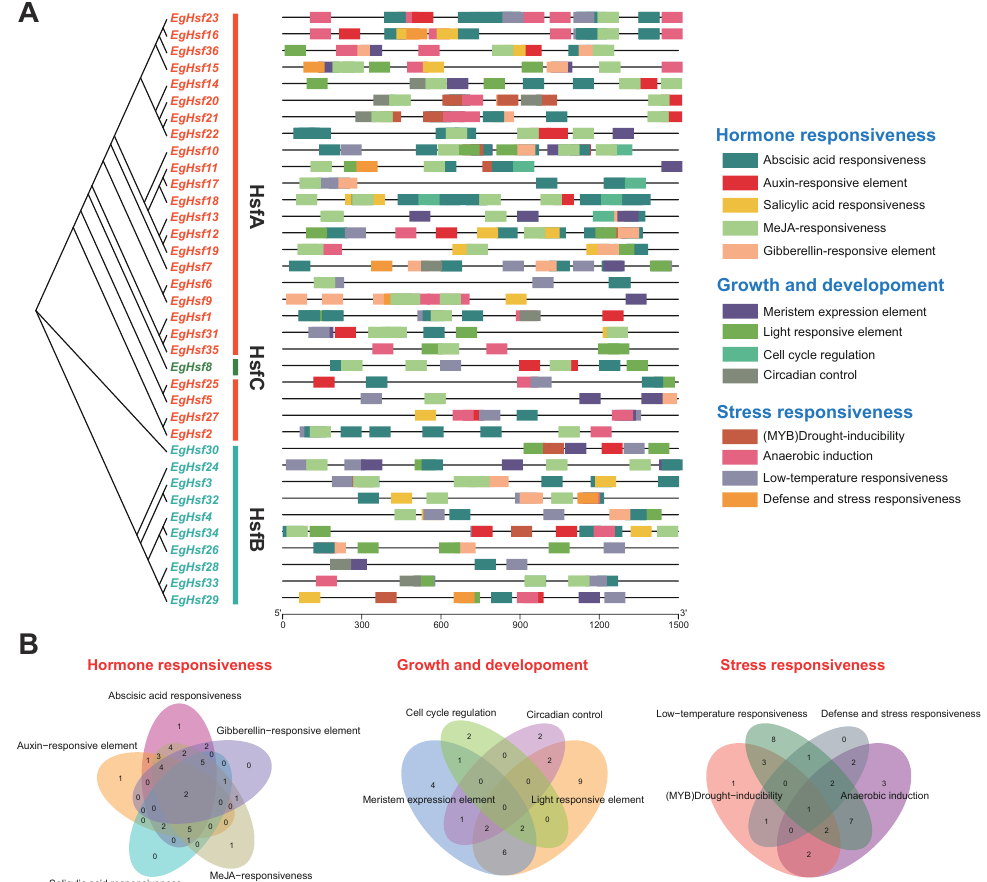
Figure 6. The cis-acting element on the putative promoter of the EgHsf genes. ( A ) Distribution of cis-acting elements identified in the 1500 bp upstream promoter region of EgHsf genes. ( B ) Venn diagram of various cis-acting